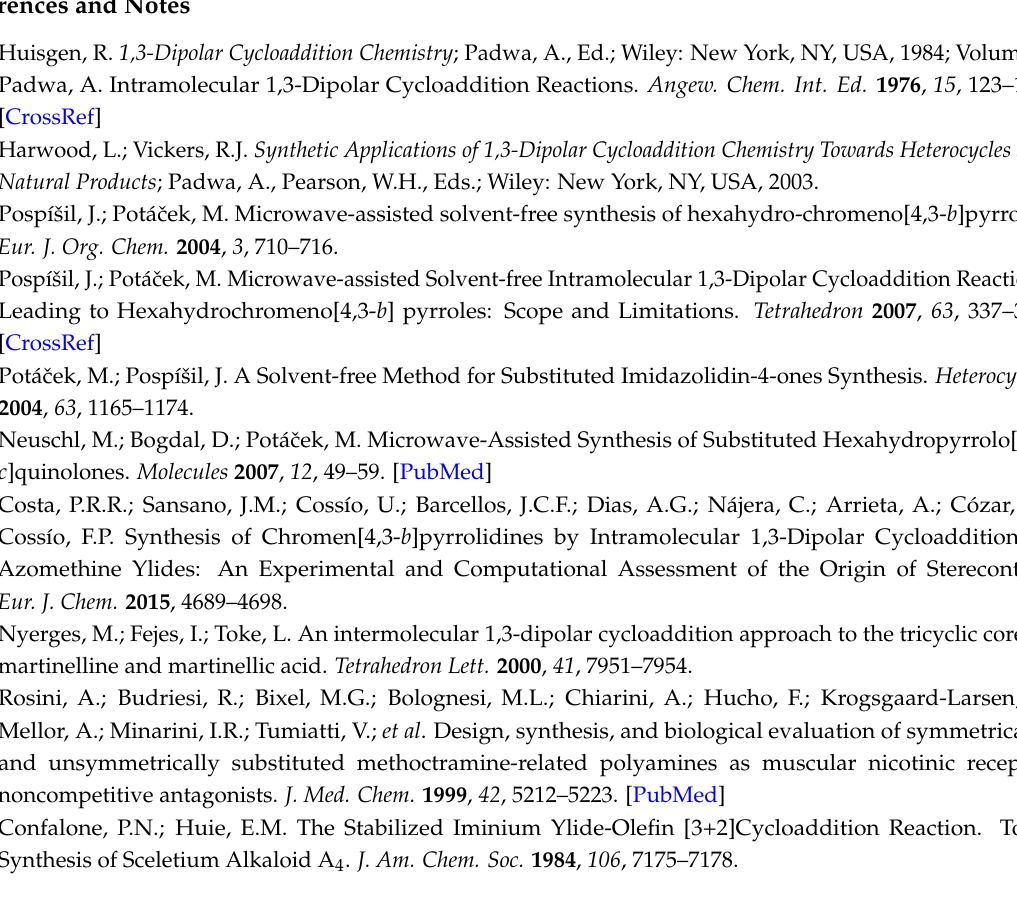
Table S1: Chemical shifts of hydrogen atoms at stereogenic centres in [ppm], Table S2. Reaction conditions and product yields in 1,3-DC, Figure S1: NOESY spectrum of compound 9Ad . 1 H-NMR and APT spectra of final compounds 9Aa – d and 9Bc in CDCl 3